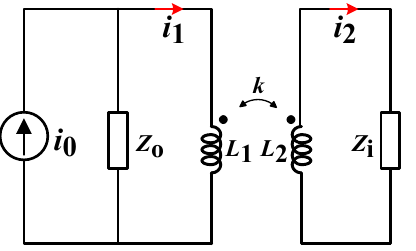
Figure 8. The current coupling model of the mixer.